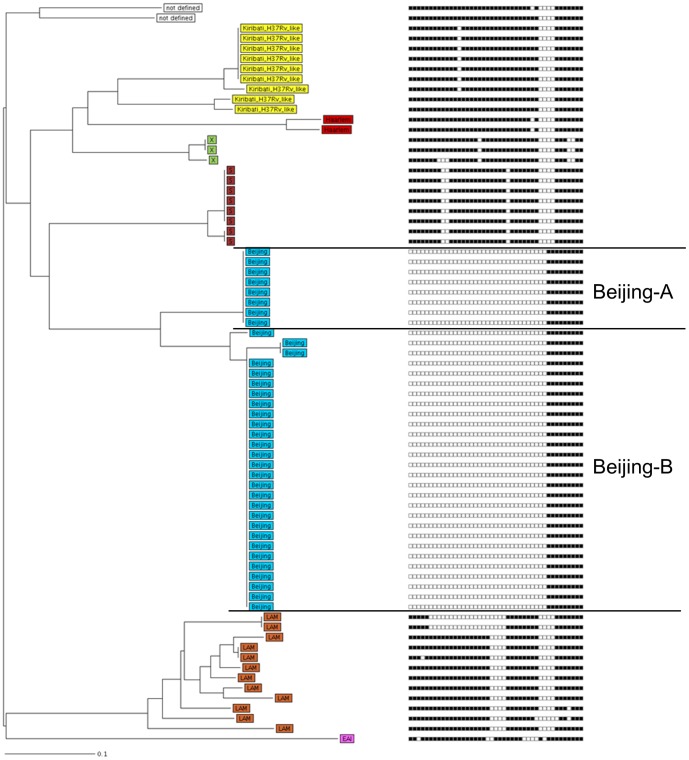
Neighbour joining tree combining 24 loci MIRU-VNTR and spoligotyping data.Neighbour joining tree (left panel) based on the copy numbers of 24 loci MIRU-VNTR (right panel, spoligotyping results whereby a repeat region's presence or absence is indicated by a black box or white box respectively) of the 73 strains investigated. The tree was calculated using the MIRU-VNTRplus server (Distance Measure: Dc: Cavalli-Sforza and Edwards, 1967: Dc [15]). Seven lineages were identified including 71 out of the 73 strains (97%), while two strains could not be allocated to a strain family. Classification of the strains into the different phylogenetic lineages is visualized by color coding, key on Figure 2.